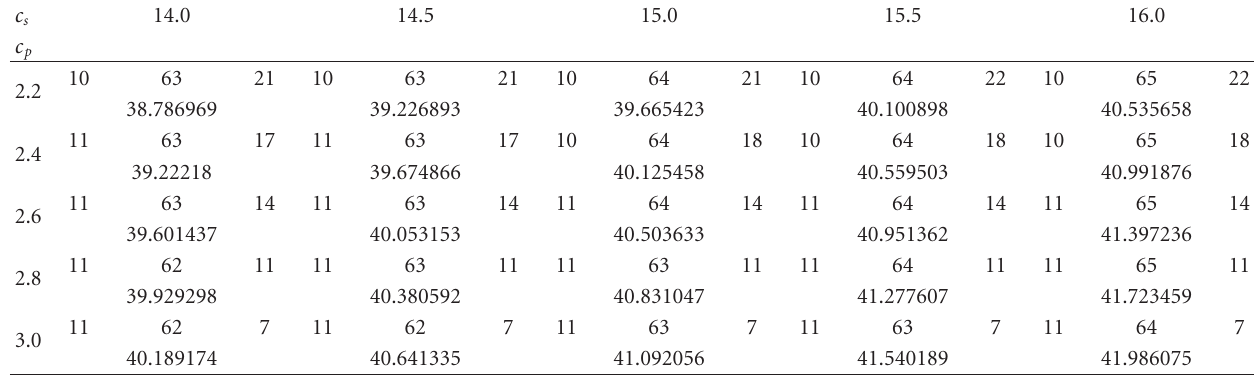
Table 15: E ff ect of c s and c p on the optimal cost rate ( c h = 0 . 3, c sh = 5, c pr = 0 . 3).